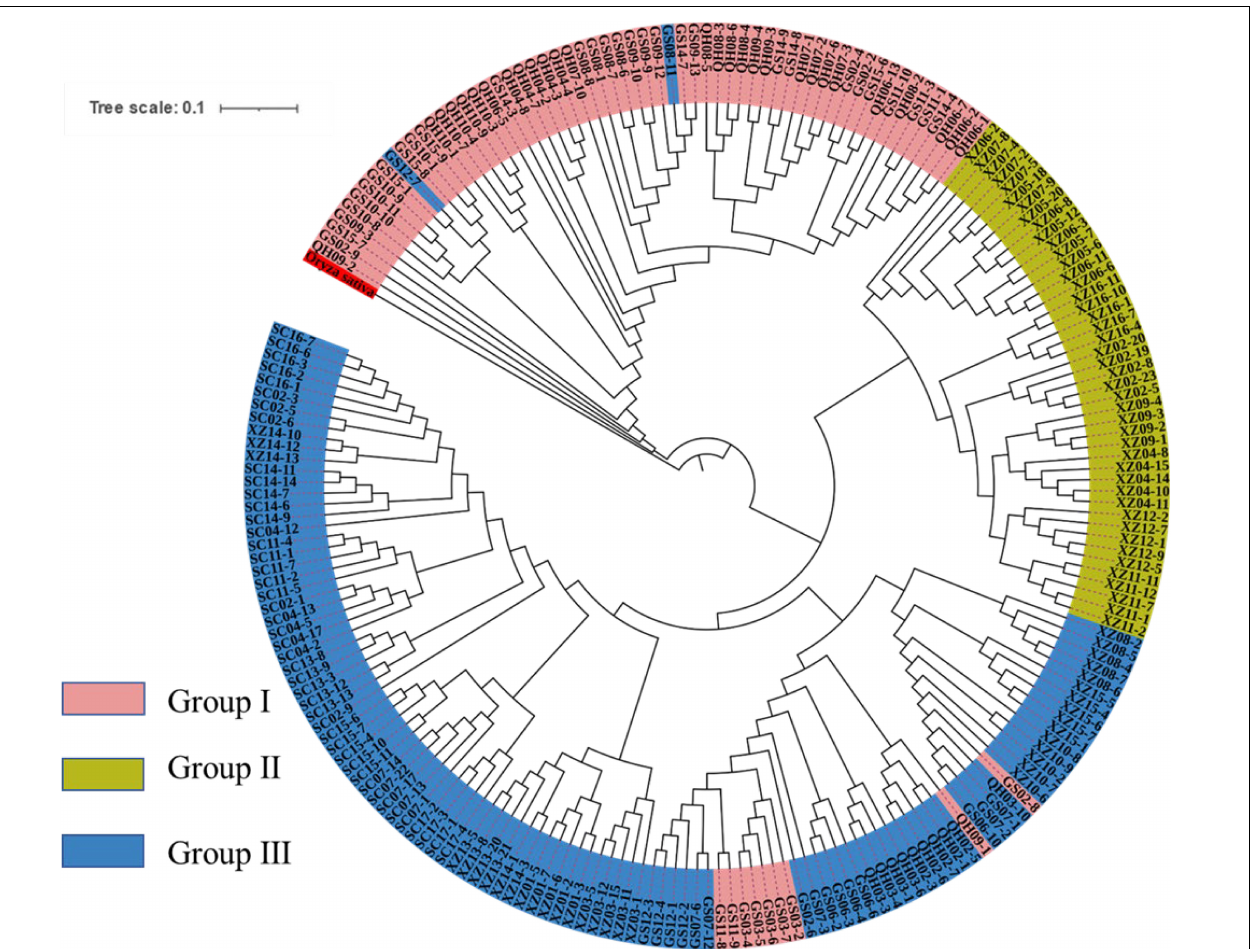
FIGURE 3 | Phylogenetic tree constructed with polymorphic SNPs between three groups.